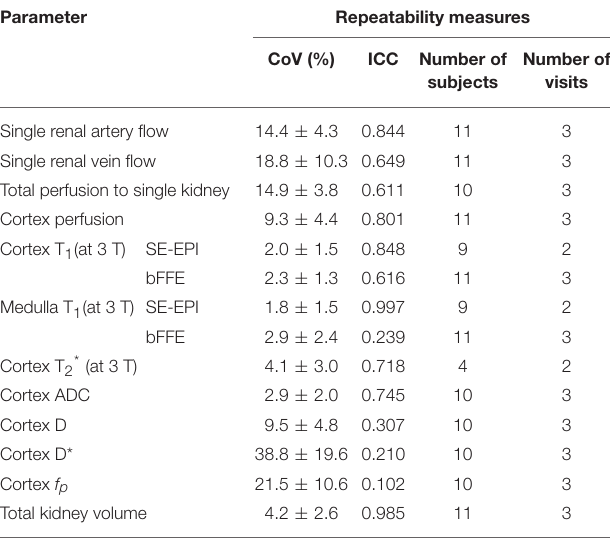
CoV (%) ICC Number of Number of subjects visits